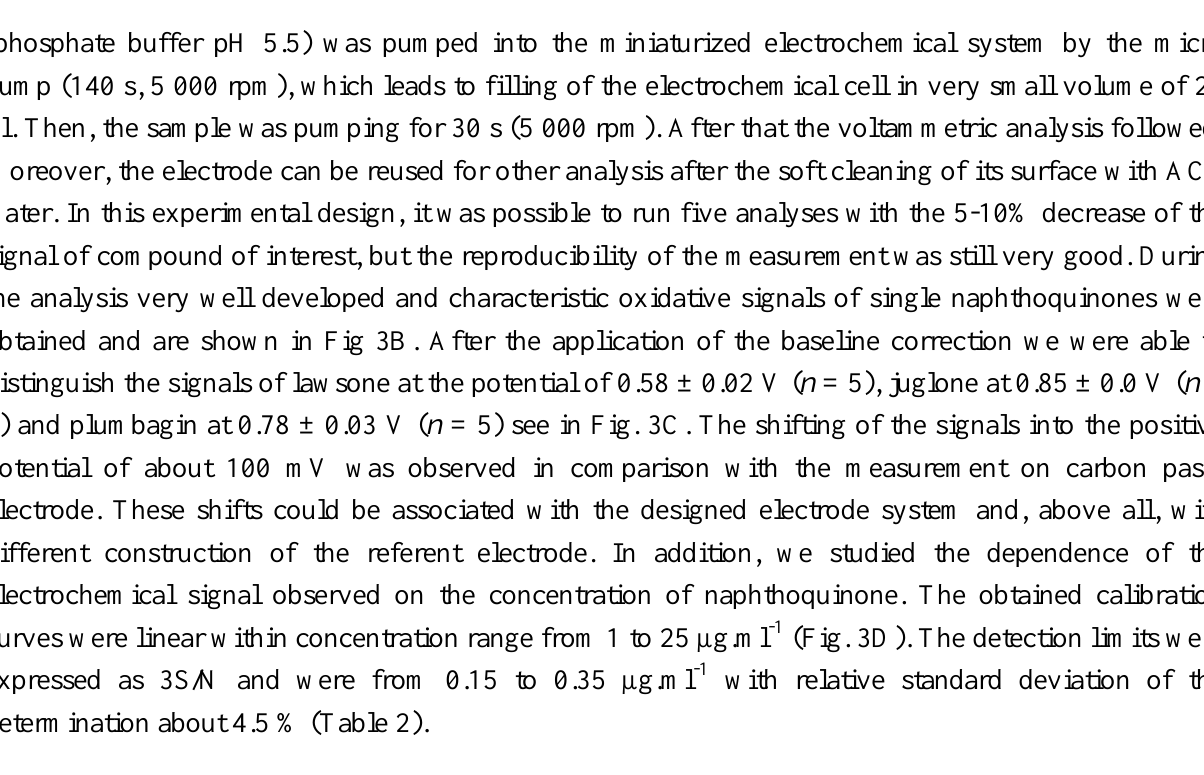
Table 2. Analysis of the naphthoquinones by micro flow analysis ( n = 5 ).